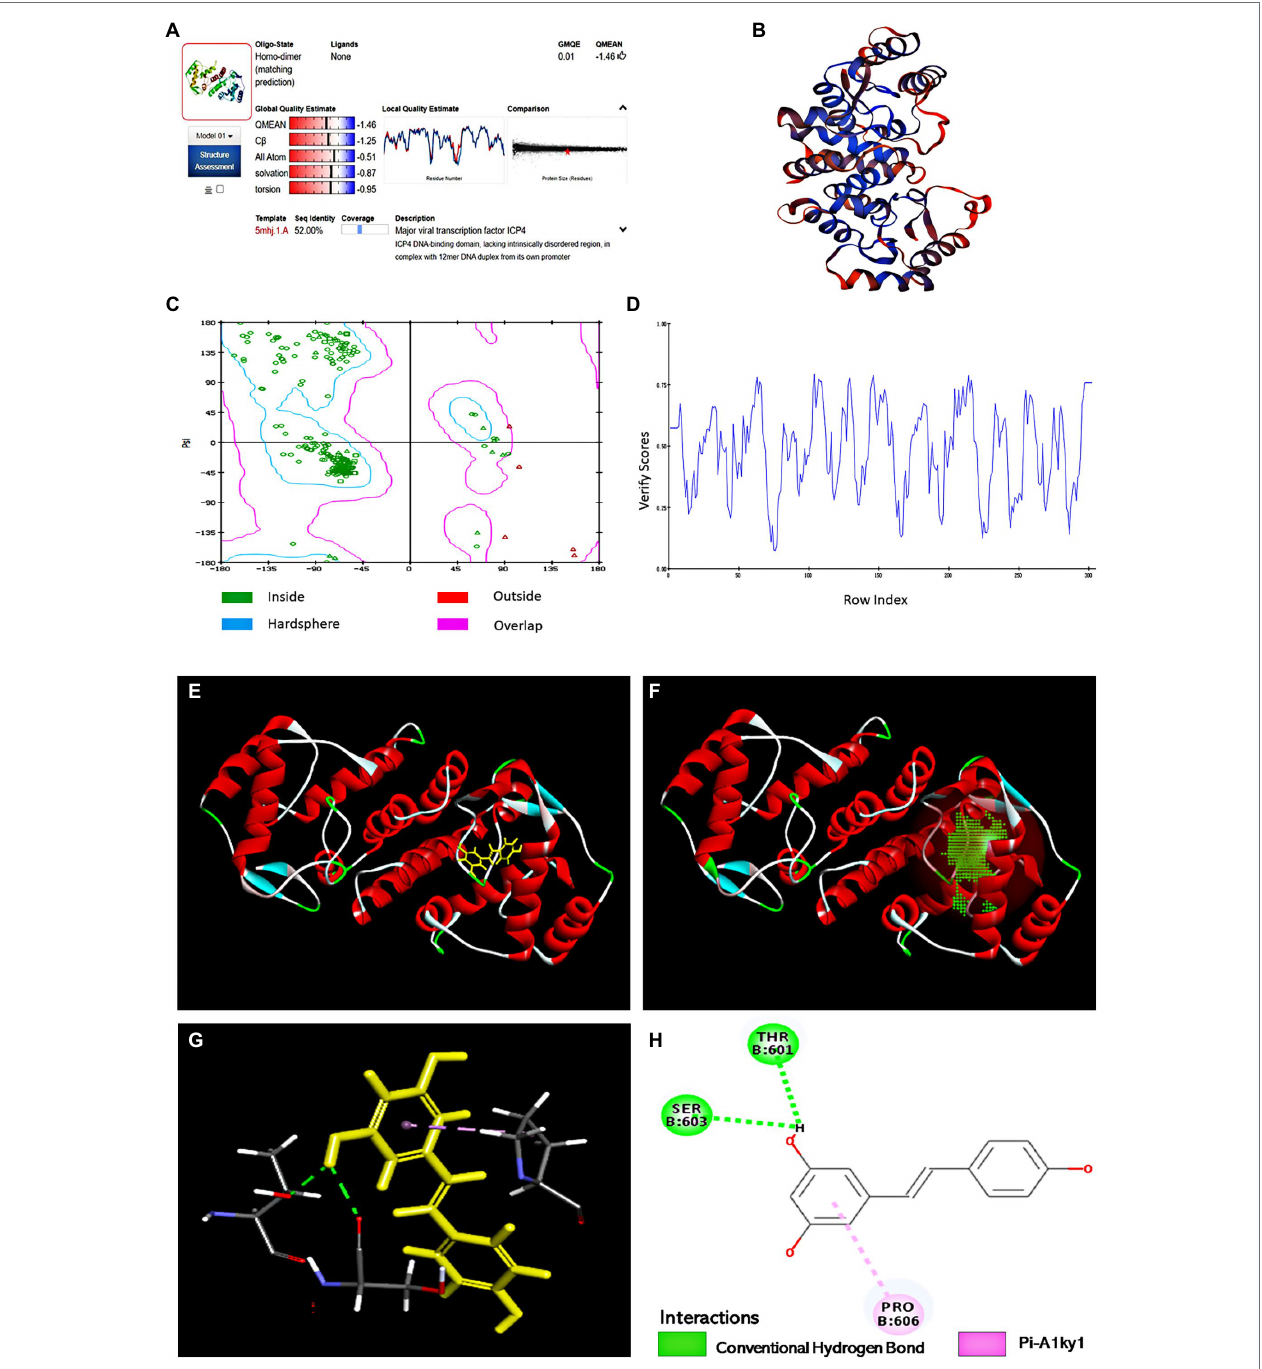
FIGURE 6 | The binding sites of Res with IE180 by molecular docking. (A) Alignment of the amino acid sequence of IE180 and ICP4 (5mhj.1. A). (B) The 3D structure of IE180 is conducted by homologous. (C) Ramachandran plots of the homologous mode of IE180 (Blue: the best region; Purple: the appropriate region; Red: the barely permitted region; and White: the disallowed region). (D) Profile 3D plot IE180 3D structure. (E) The 3D structure of IE180 includes an active docking site. (F) 3D docking mode between Res and IE180simulated by Discovery Studio. (G) The interaction of IE180 with Res; the green and purple colors represent H-bond and Pi-Alkyl, respectively. (H) 2D schematic interaction diagram between IE180 and Res; the green color and purple color represent H-bond and Pi-Alkyl,